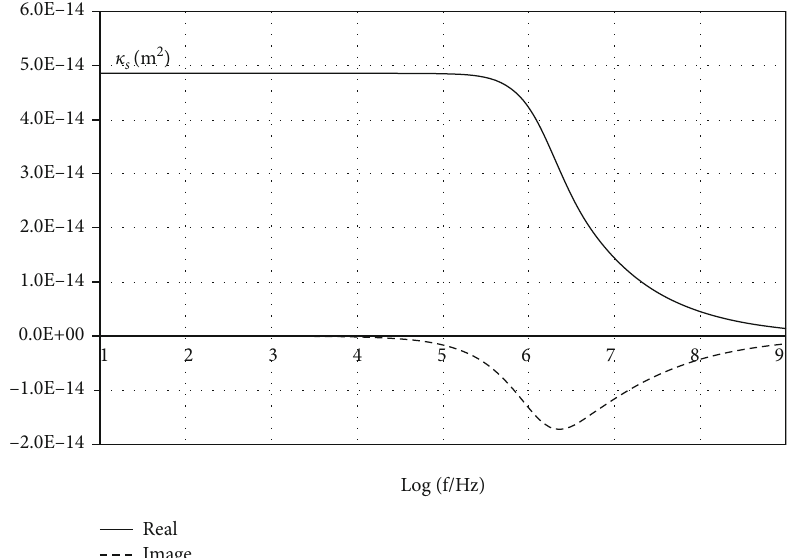
f ), for water-saturated D ’ Euville limestone under di ff erential pressure of